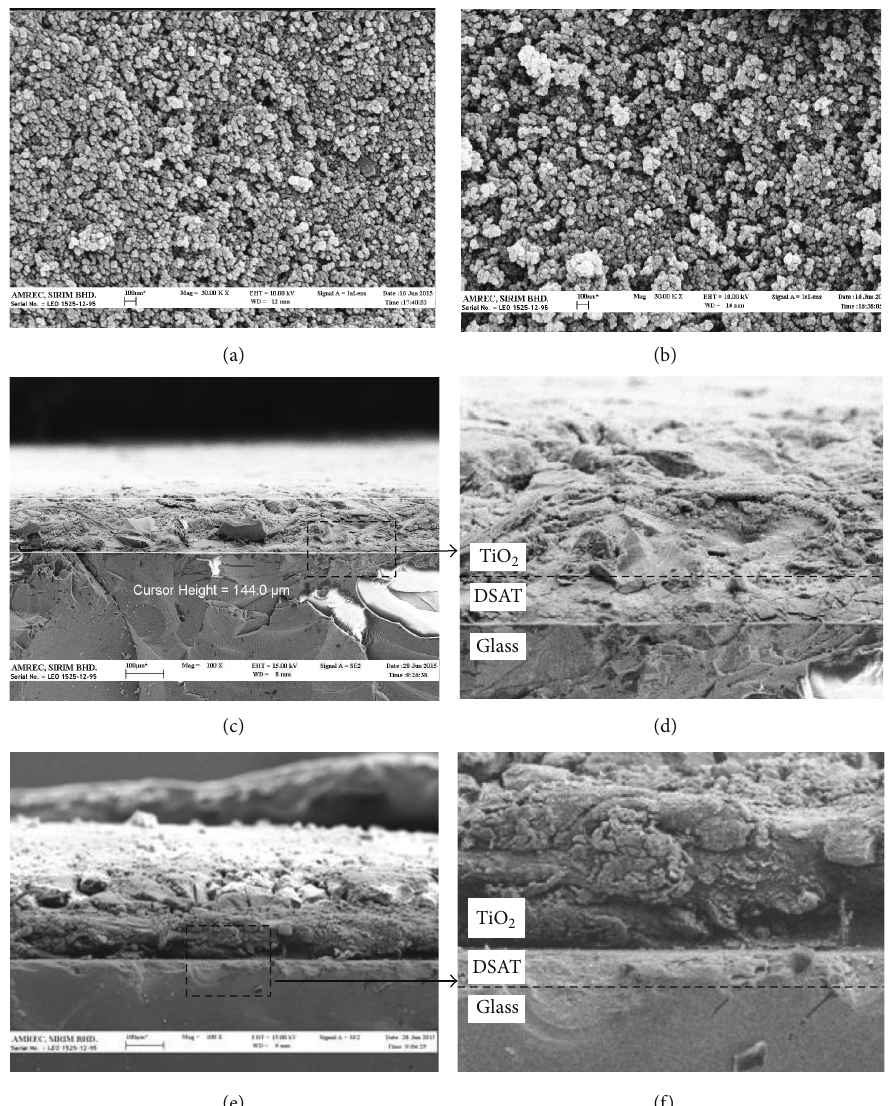
Figure 4: SEM images surface morphology of immobilized TiO 2 /DSAT (a) for 1st cycle of photodegradation process of RR4 and (b) after 30 cycles under photodegradation process of RR4. Cross section images of (c) immobilized TiO 2 /DSAT under heating process; (d) magnification image for immobilized TiO 2 /DSAT under heating process; (e) immobilized TiO 2 /DSAT without heating process; and (f) magnification image for immobilized TiO 2 /DSAT without heating